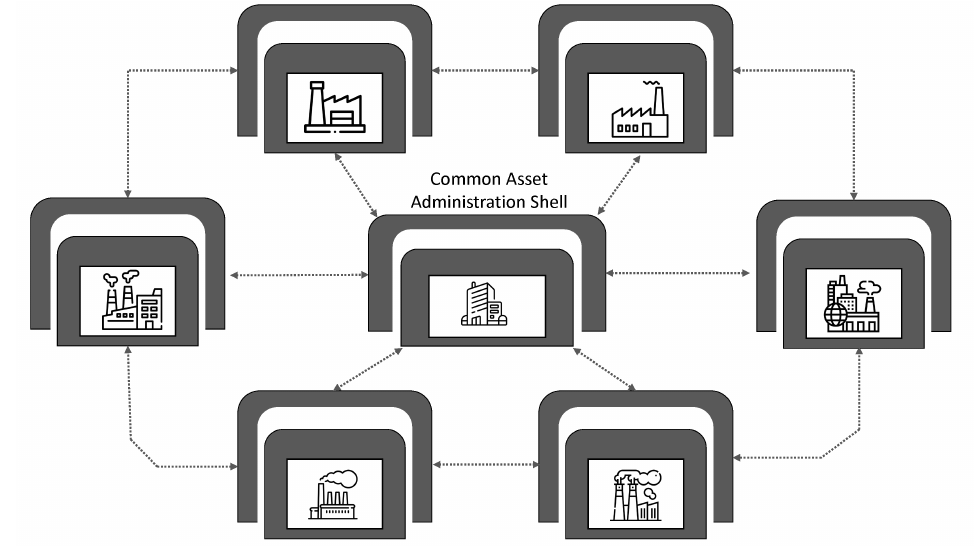
Figure 14. Common inter-factory (factory-to-factory) asset administration shell.